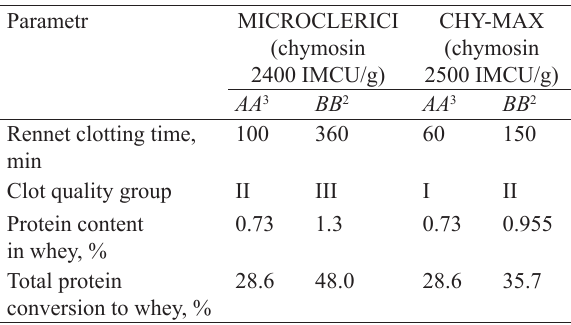
Table 10 Assessment of cheese suitability of reconstituted dried milk from cows with different CSN3 genotypes by rennet-fermenting